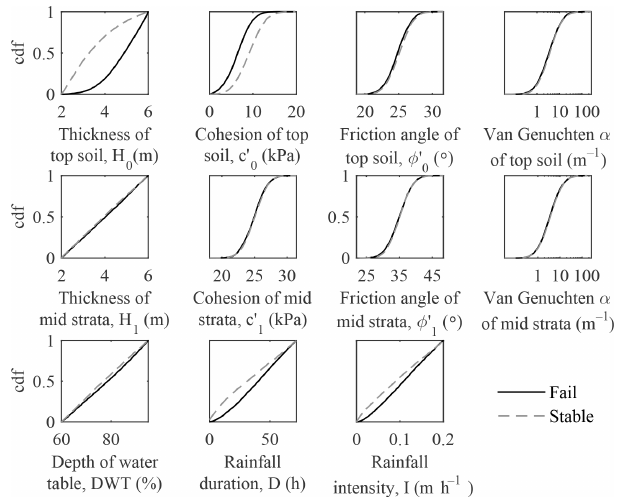
Figure 4. Cumulative probability distributions (cdf) of slope fail- ure and stability predicted by CHASM for several different input factors. Note that the Van Genuchten suction–moisture curve α is shown in logarithmic